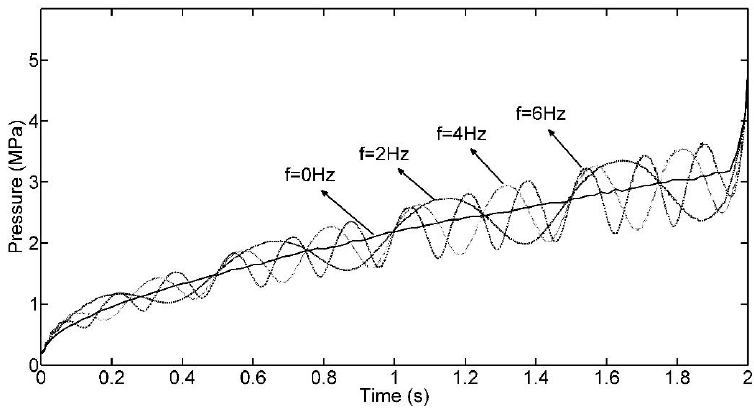
Figure 8. Injection pressure curves with different f fill .